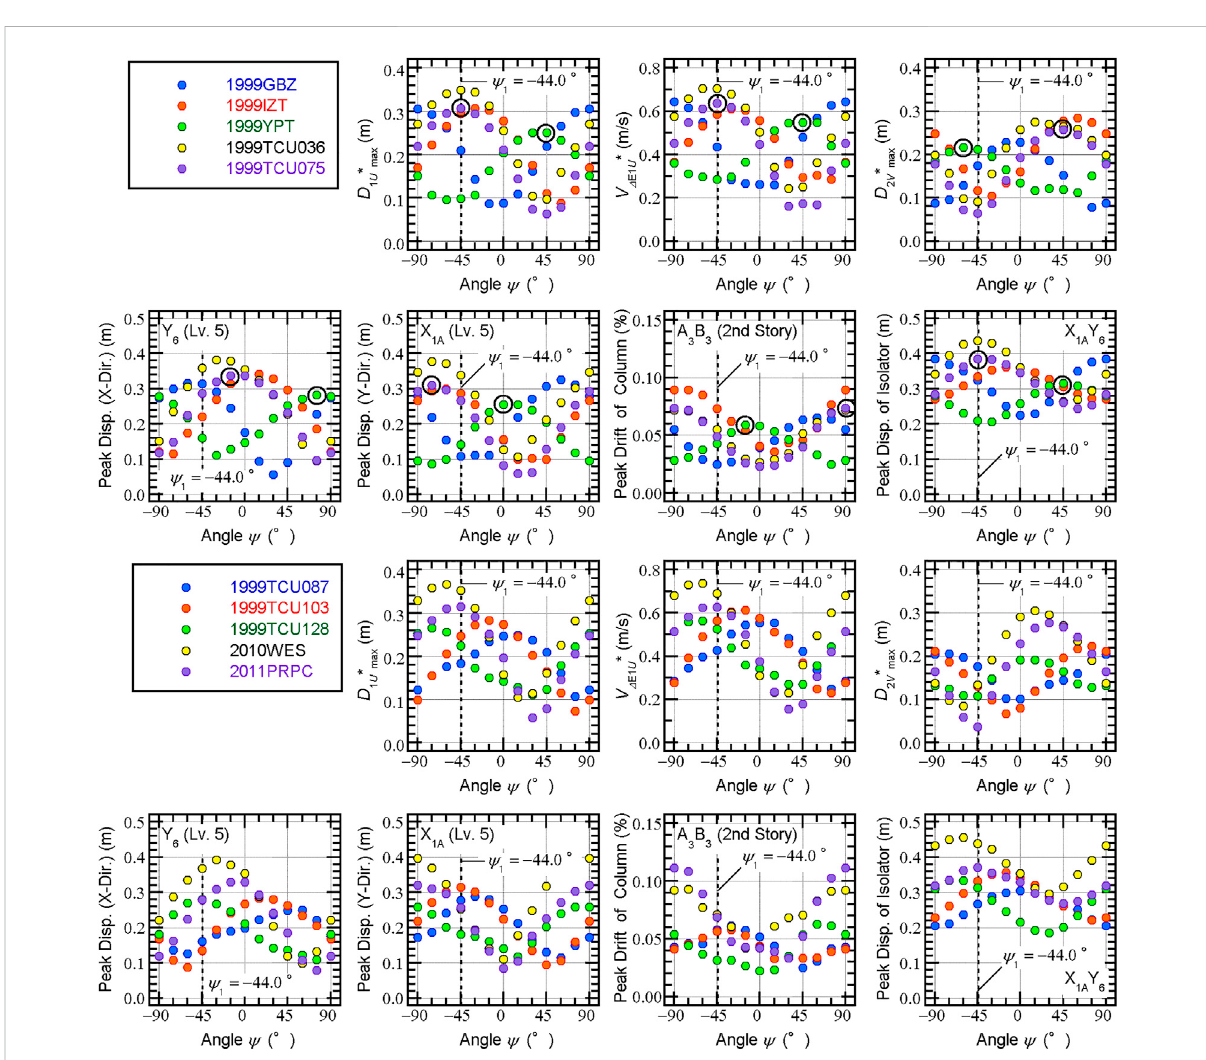
FIGURE 9 Relationshipbetweenthepeakresponseandtheangleofseismicincidence(ASI)de fi nedintermsoftheprincipalaxisofArias.Notethattheplot at − 90 ° is added to consider the symmetricity: the plots at − 90 ° and 90 ° are the same. The black circled plots indicate the largest responses for the 1999YPT and 1999TCU075